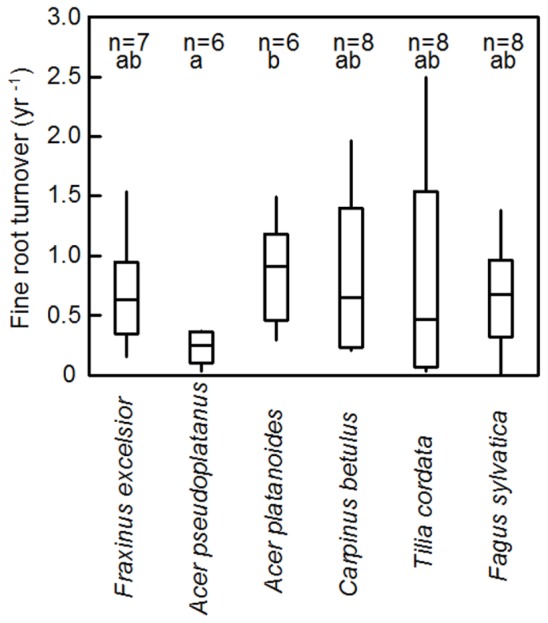
Median fine root turnover (year-1) of the six tree species according to ingrowth core data for the 0–30 cm profile. Given are the median, the 25- and 75- percentiles and the minima and maxima. Significant differences (p < 0.05) between the species are indicated by different letters.